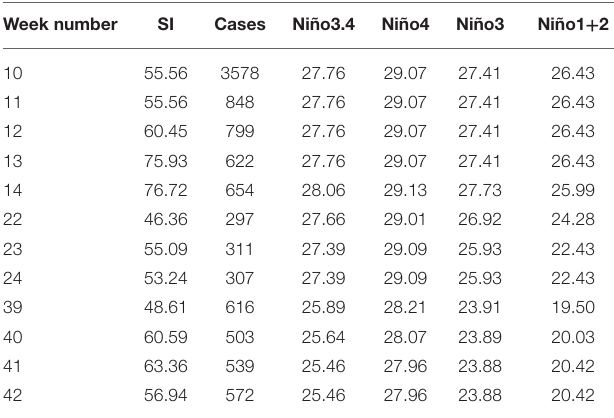
TABLE 4 | Changes in SI and Niño SST indices